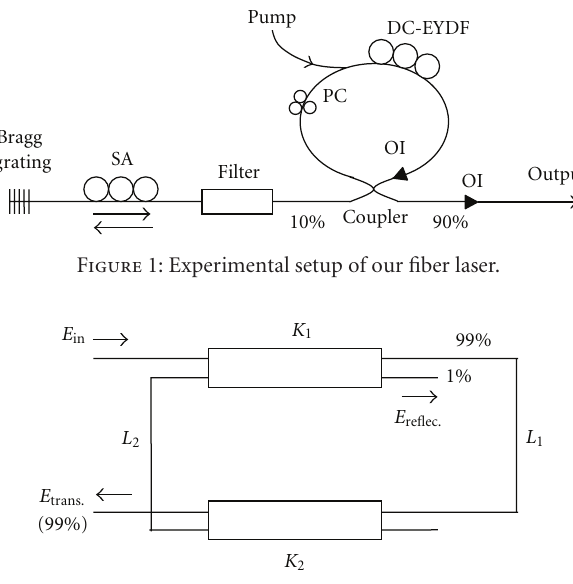
Figure 2: All-fiber Fabry-Perot filter [22].